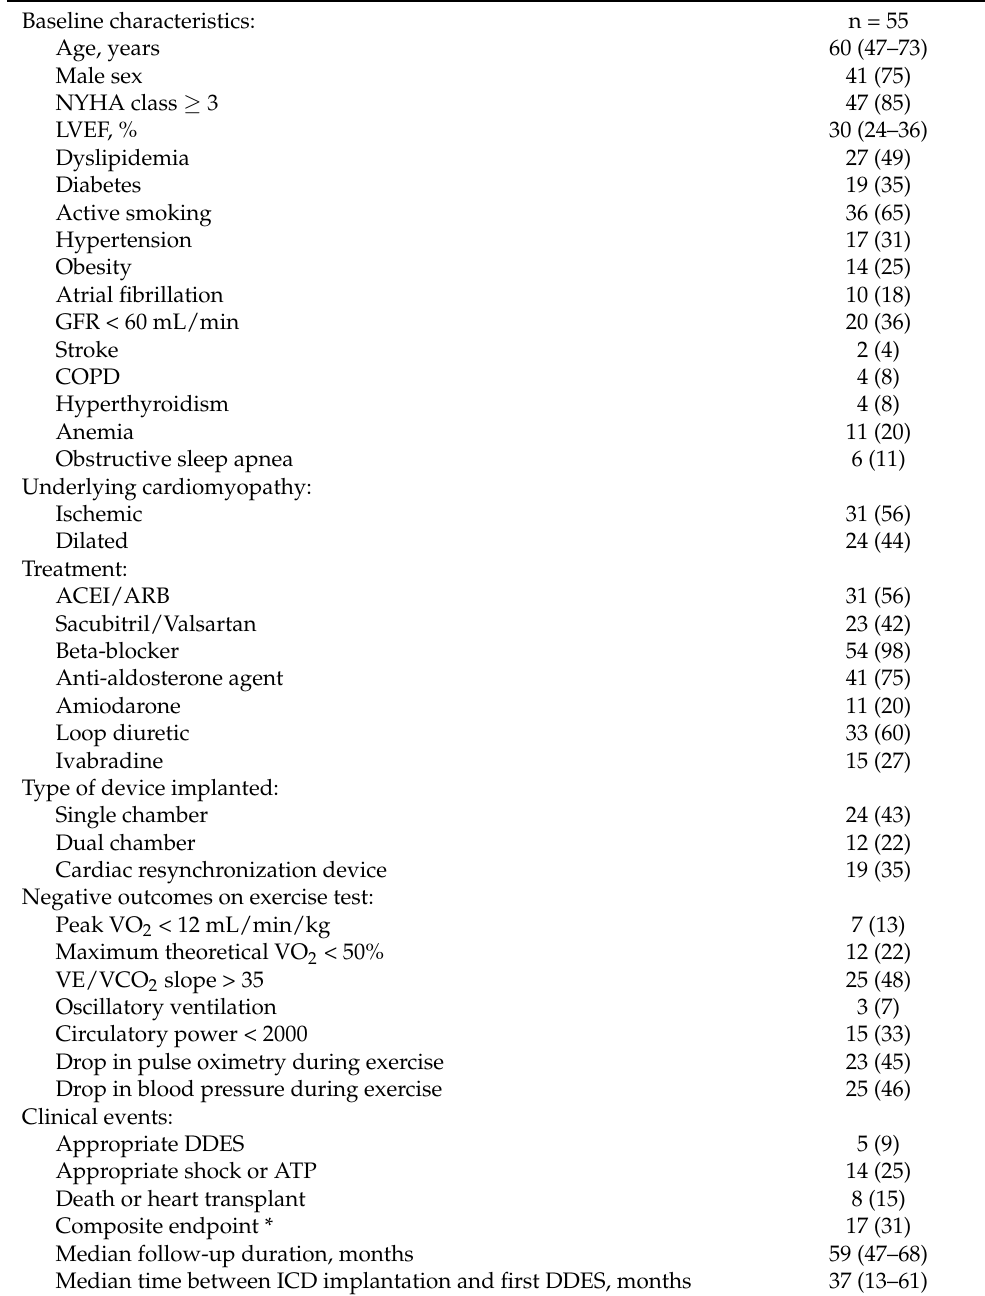
Table 1. Baseline characteristics of the study population and events during